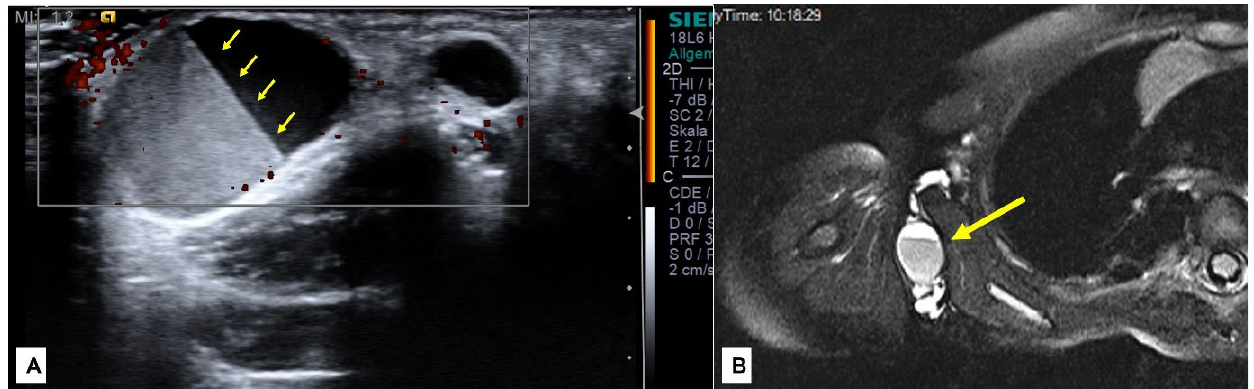
Figure 5. A 2.5-year-old girl with a sudden appearance of a lump in the right axilla. Ultrasound examination showed a multi-cystic mass with intracystic bleeding documented by the fluid-fluid level in the cyst representing the clot retraction ( A )—(yellow arrows). The MRI ( B ) showed the exact extension of the mass (arrow), which was limited to the subcutaneous tissue and facilitated the indication for surgical resection.